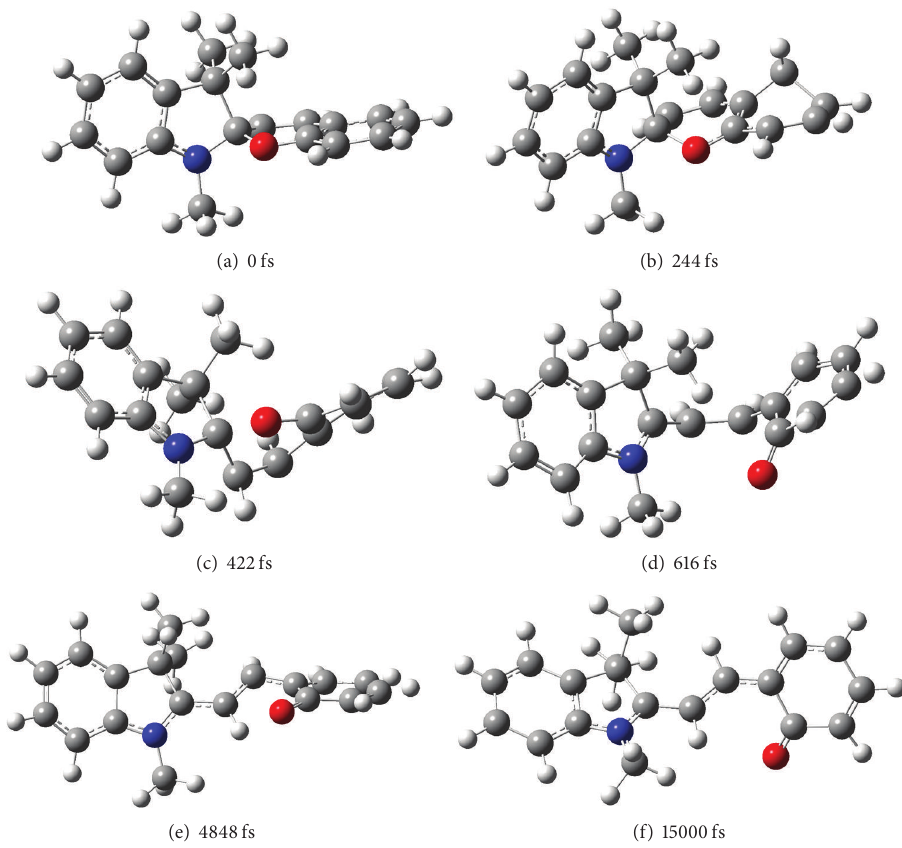
Figure 4: Snapshots taken at different times in a simulation of trans-SP in response to excitation by a 80fs (FWHM) laser pulse with a fluence of 0.139kJ/m 2 and photon energy of 3.972 eV, Atom C, H, N, and O are, respectively, denoted by dark grey, French grey, blue, and red; (a)–(f) are at 0 fs, 244 fs, 422 fs, 616fs, 4848 fs, and 15000 fs, respectively [41].